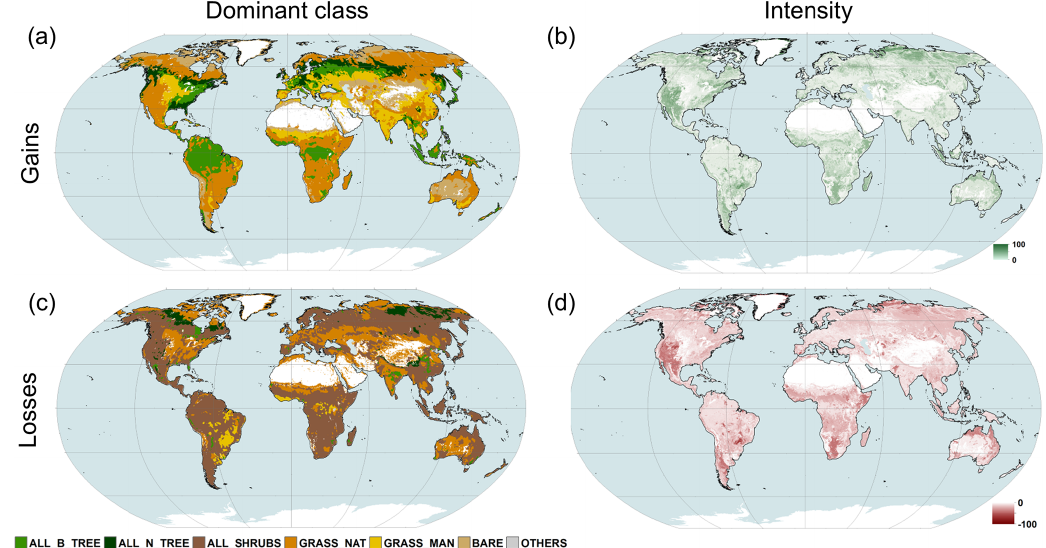
Figure A3. PFT with the largest increase (a) and largest loss (c) in coverage within 0 . 25 ◦ × 0 . 25 ◦ pixels in the PFT local dataset compared to the PFT global and corresponding fractions gained (b) and lost (d) . White areas remained stable in both PFT